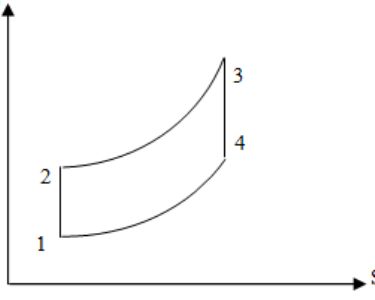
Figure 4. T-S (Temperature-Entropy) chart of the Brayton cycle.